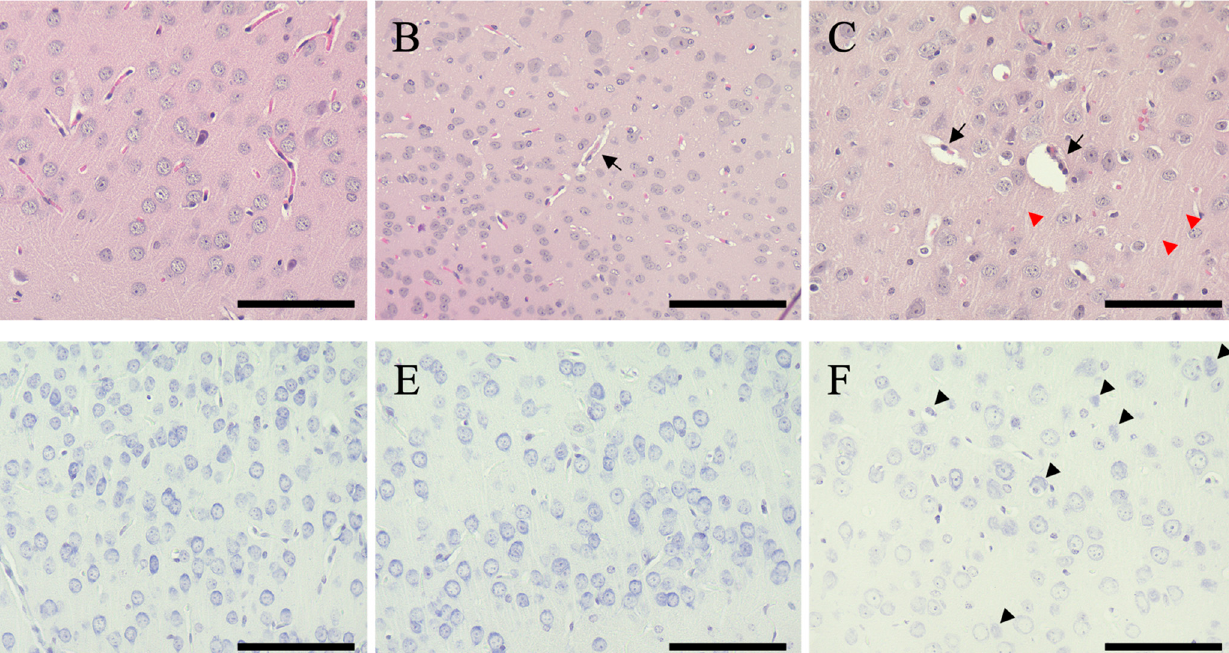
Figure 5. Control ( A , D ), 3H ( B , E ), and 24H ( C , F ) representative optical images of the cerebral corti- cal tissues from the control animals and those from animals sacri fi ced at 3 h and 24 h after ammonia treatment, respectively. ( A – C ) are high-magni fi cation views of the hematoxylin-eosin-stained cere- bral cortical tissues. ( D – F ) are high-magni fi cation views of the Nissl-stained cerebral cortical tissues. The black arrows indicate perivascular edema of the cerebral cortex layer II/III. Red arrowheads indicate the swollen fi bers of the cerebral cortex layer II/III. Black arrowheads indicate the neuronal atrophy of the cerebral cortex layer II/III. All scale bars = 100 µm. ( G ) shows the relative intensity of Nissl-stained neurons. Data are shown as relative intensity (100 = the intensity of the control value). ( H ) shows the number of atrophying neurons. Data are expressed as mean ± standard deviation. *: p < 0.05 compared with the control value. The structural changes observed in the optical microscope were further examined in detail using a transmission electron microscope (Figure 6). First, regarding perivascular pathological changes, perivascular edema was observed in both ammonia-treated groups compared with the control group (blue arrowheads in Figure 6B,C). However, no damage was observed in the basal membrane (black double arrowheads in Figure 6A–C) or vas- cular endothelial cells. Second, regarding pathological changes in neuronal cell bodies of neurons , many intracellular organelles, such as the rough endoplasmic reticulum (black